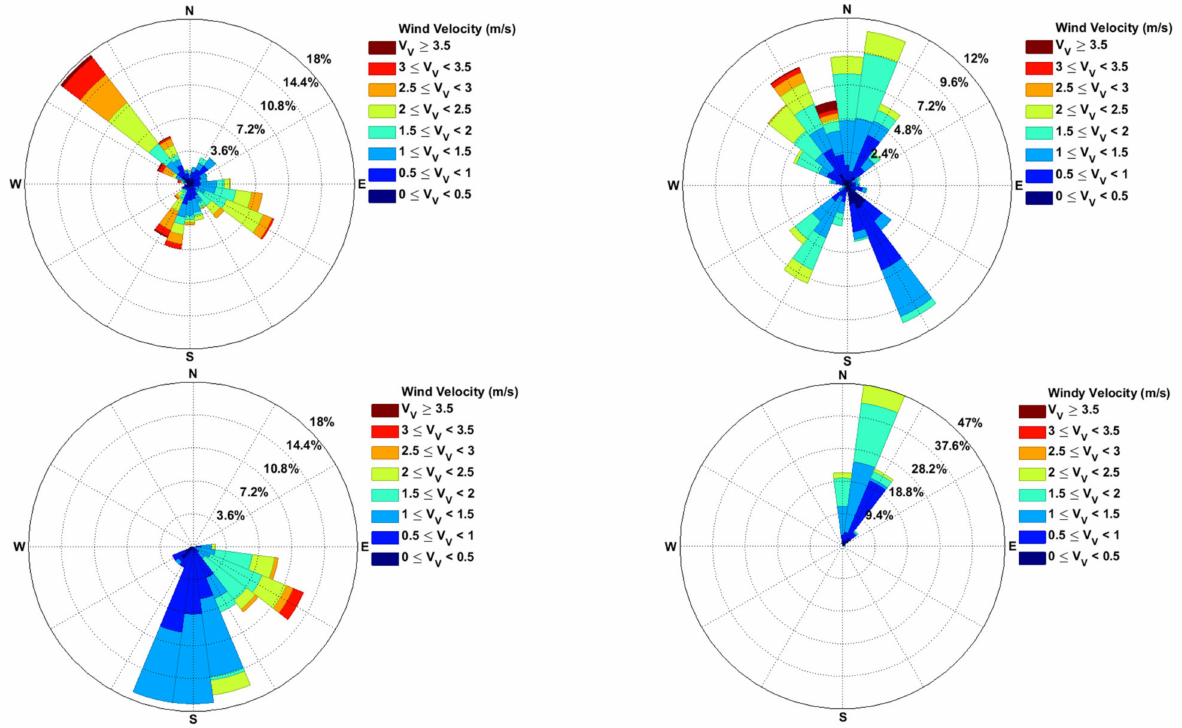
Figure 10. Wind roses for the full day ( upper panels ) and during land breeze occurrences ( lower panels ) for Barbosa station in the left panels and for Cid Almeida station in the right panels, on 3 August